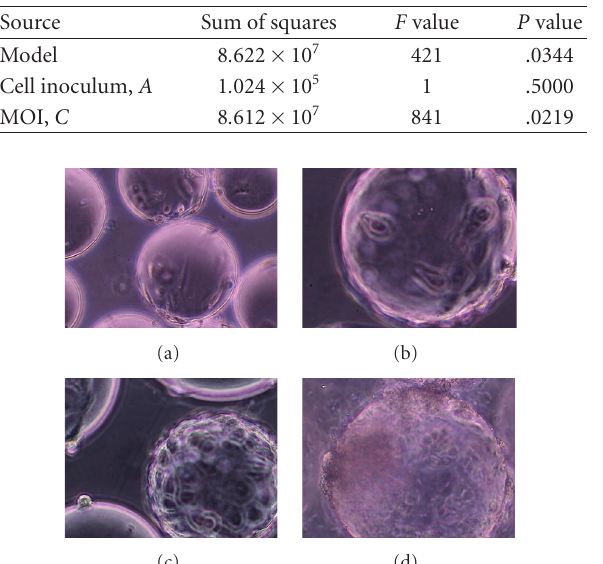
Table 4: Analysis of variance (ANOVA) for Taguchi L4 model.